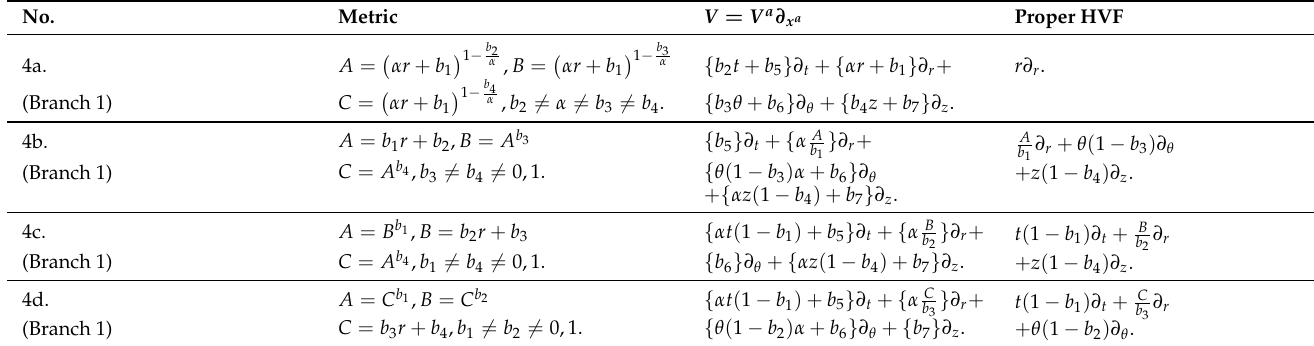
Table 1. Metrics admitting four